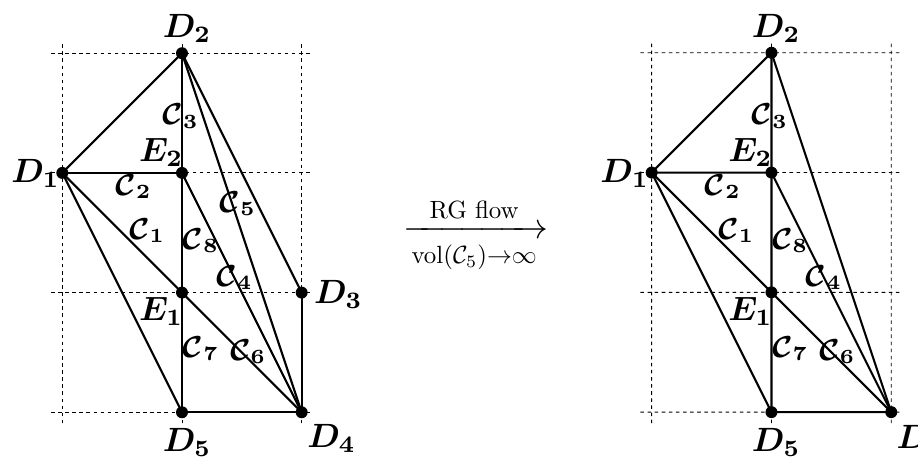
Figure 26 . Decoupling the divisor D 3 leads to a crepant resolution of the E 12 ; 1 singularity.